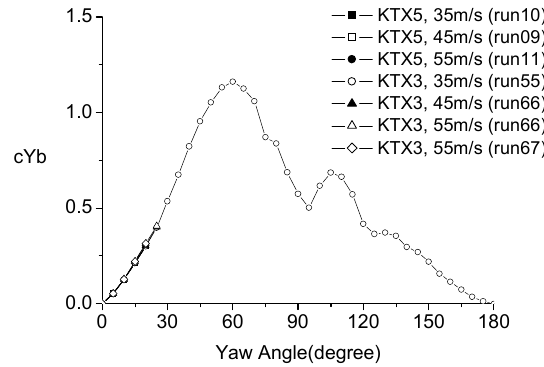
Figure 4 Side force coefficient (KTX